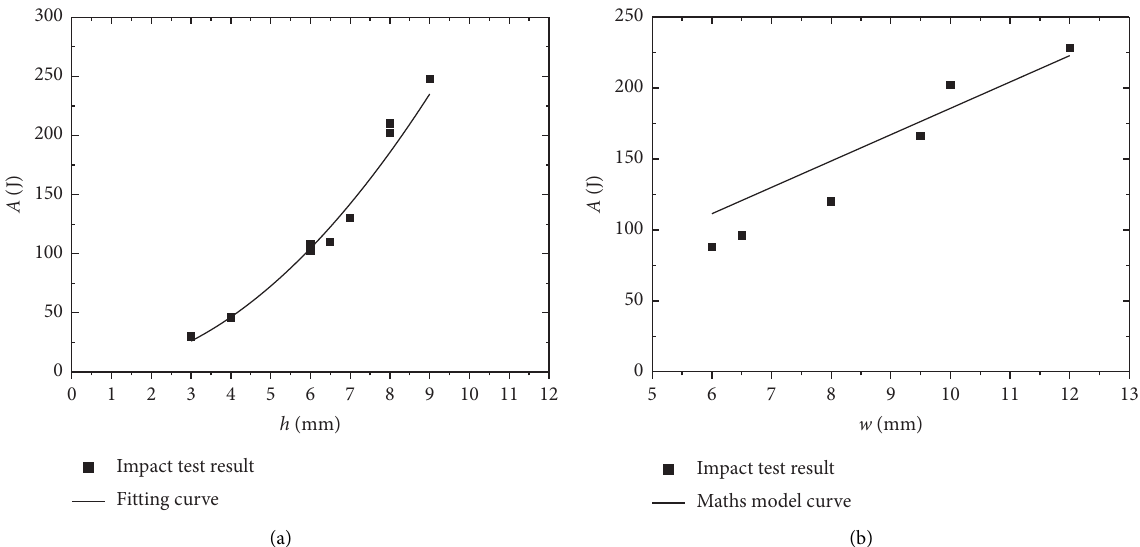
Figure 4: Comparison of evaluations based on model and impact test results for 921 steel. (a) A1 ∼ A9 specimen impact test results. (b) A10 ∼ A15 specimen impact test